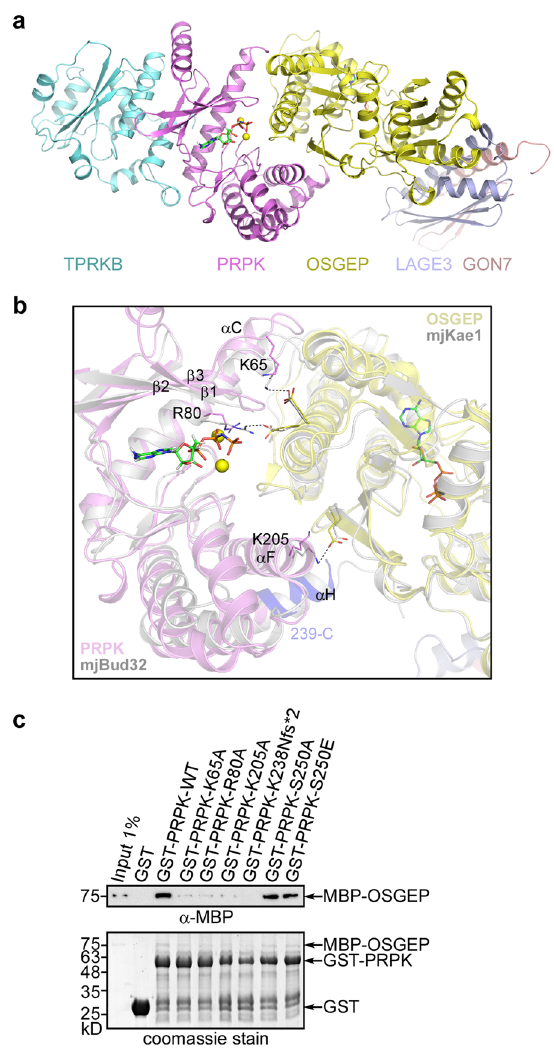
Fig. 6 A model of the human EKC/KEOPS complex. a The human EKC/ KEOPS complex structural model, composed of TPRKB, PRPK, OSGEP, LAGE3, and GON7, is constructed by aligning our structure and the OSGEP – LAGE3 – GON7 structure (PDB ID 6GWJ) to the mjBud32 – Kae1 structure (PDB ID 3EN9). AMPPNP is shown as stick and Mg 2 + as yellow spheres. b Detailed view of the interface between PRPK (violet) and OSGEP (yellow) in our model, aligned to the mjBud32 – Kae1 crystal structure (gray). Three salt bridges found in mjBud32 – Kae1 appear conserved at the PRPK – OSGEP interface. The involved residues in PRPK are K65, R80, and K205. The region deleted in the PRPK K238Nfs*2 mutant (residues 239-C) is colored light blue. c Pulldown of MBP-tagged OSGEP by GST-tagged PRPK mutants. GST-tagged PRPK was fi rst immobilized on glutathione Sepharose beads and then incubated with a puri fi ed MBP- tagged OSGEP protein. After extensive washing, MBP-OSGEP bound to PRPK was detected using an MBP antibody. A representative result from at least 3 repetitions is shown. Uncropped images of gel and blot are shown in Supplementary Fig.